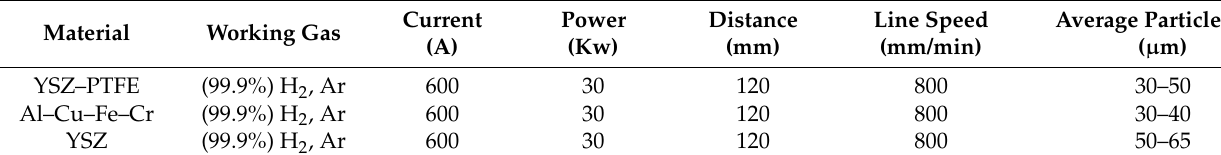
Table 3. Deposition parameters.